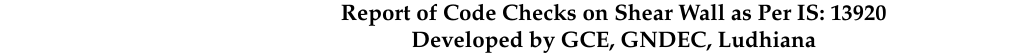
Table 8. Report File Generated for Shear Wall 3.